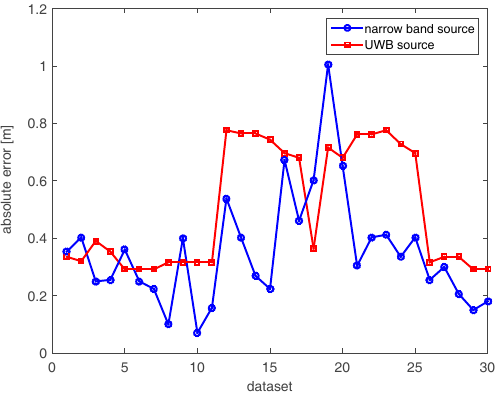
Figure 20. Positioning errors achieved with multiplicative array image fusion (E).